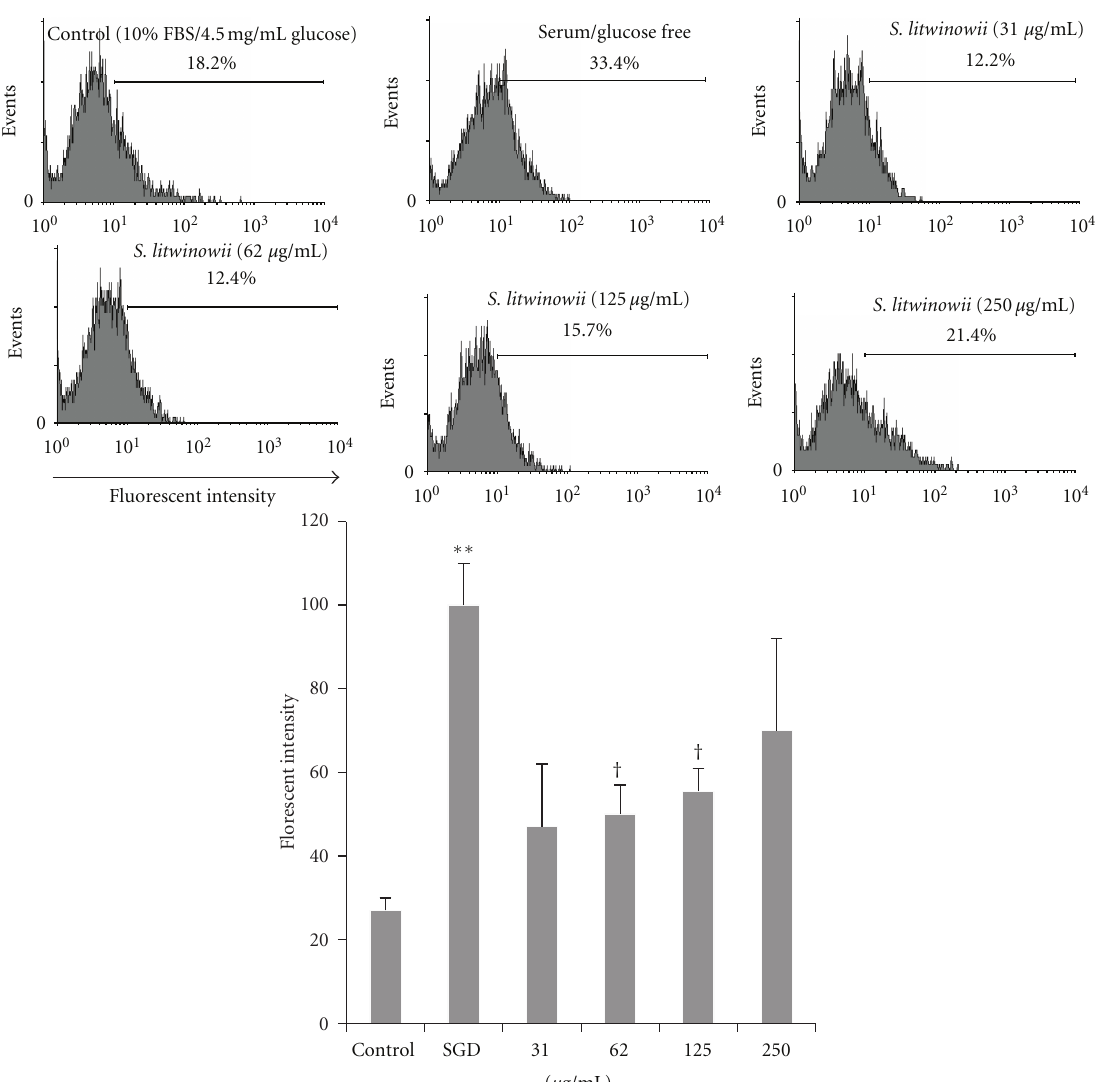
Figure 2: Flow cytometry with DCFH-DA staining for measuring ROS production for cultured PC12 cells in control group, serum/glucose deprivation alone group, and pretreatment with S. litwinowii (15–250 μ g/mL) plus exposure to serum/glucose deprivation. In the pretreatment groups, the PC12 cells were exposed to serum/glucose deprivation in the presence of S. litwinowii (15–250 μ g/mL) for only 24h. The ROS production was assessed according to changes in the fluorescence intensity of DCF, the oxidation product of DCFH-DA. The data presented are means ± SEM of three independent experiments ( n = 3). ∗ : P value < 0.001 relative to control group; † : P value < 0.05 relative to